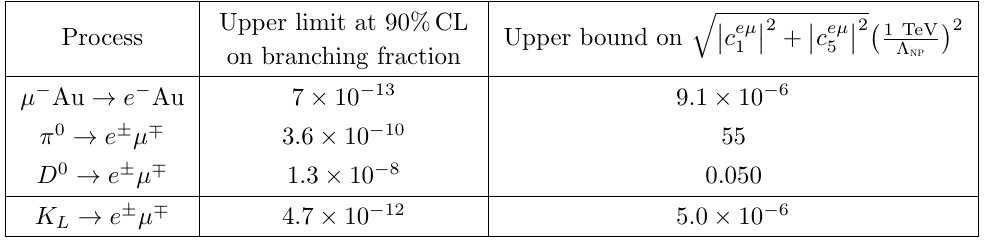
Table 3 . Bounds from processes without hyperons on c e(cid:22) the only ones